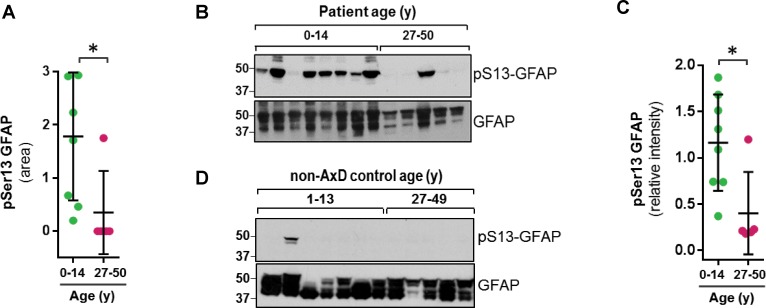
GFAP is phosphorylated on head domain Ser13 primarily in AxD brain from young patients.(A) Quantification of pSer13-GFAP abundance by mass spectrometry in young (green) vs. old (pink) AxD patients (*=p < 0.05 unpaired t-test). (B) Validation of pSer13-GFAP by western blot of HSE from AxD patients, using a phospho-specific antibody to pSer13-GFAP. The order of samples, by AxD donor ID number, is: 1482, 1070, 885, 5488, 1161, 2768, 338, 613, 5377, 5517, M3596, 5109, and 4858 (listed in Supplementary file 1). (C) Quantification of the relative intensity of pSer13-GFAP on western blot in young (green) and old (pink) AxD patients (*=p < 0.05 unpaired t-test). Signal intensity was normalized to total GFAP in each sample. (D) Western blot of pSer13-GFAP in non-AxD control brain lysates of different ages. The order of samples, by donor ID number, is: 1547, 5941, 103, 1791, 1670, 4898, 1706, 1711, 1011, 632, 4640, and 4915 (listed in Supplementary file 2).Figure 2—source data 1.Raw data from mass spectrometry PTM profiling of GFAP extracted from AxD and control human brain.